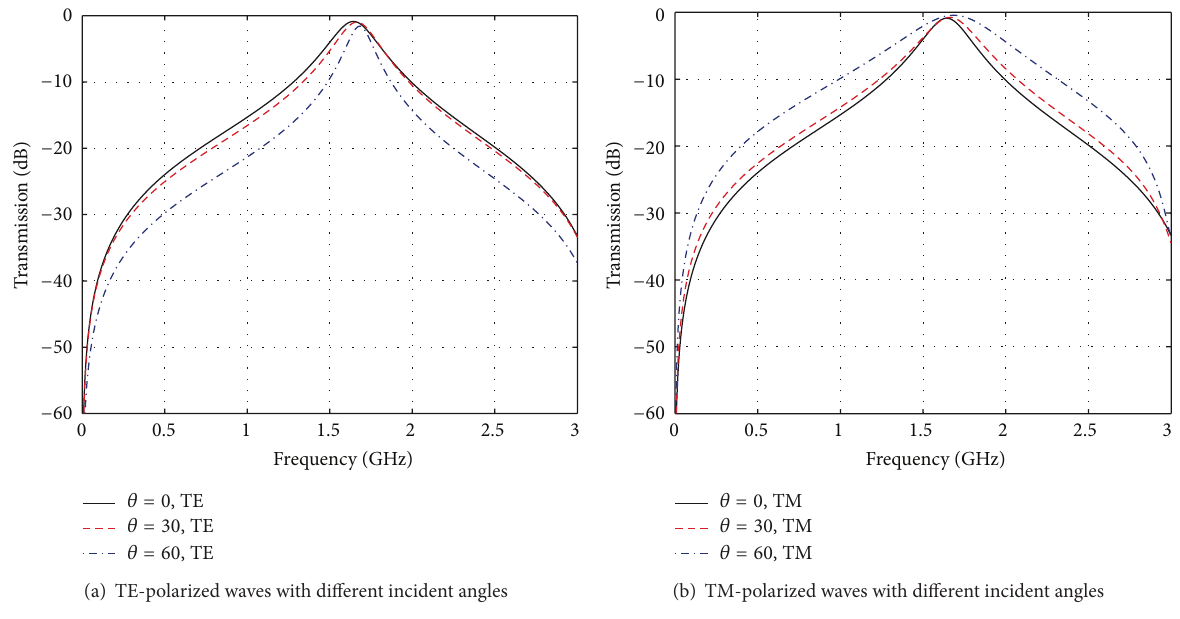
Figure 10: Transmission coefficients of the proposed miniaturized FSS with different modes.